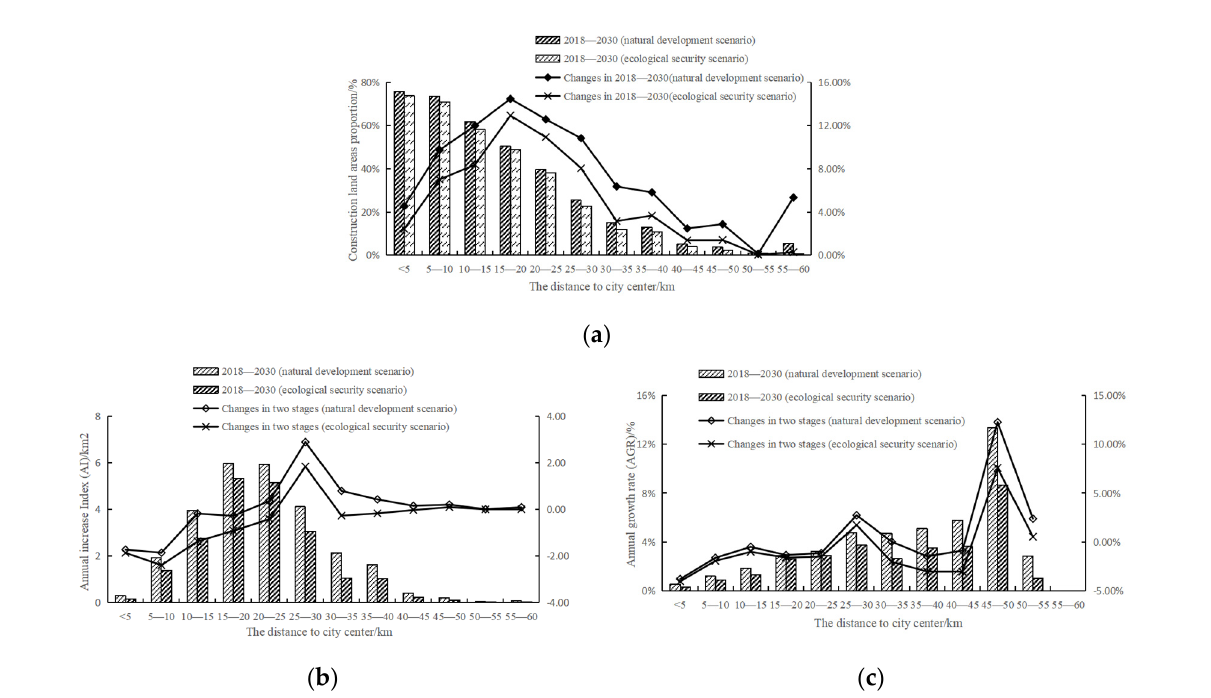
Figure 10. Characteristics of urban expansion in different directions under different scenarios: ( a ) construction land area proportion; ( b ) annual increase index (AI); ( c ) annual growth rate (AGR).